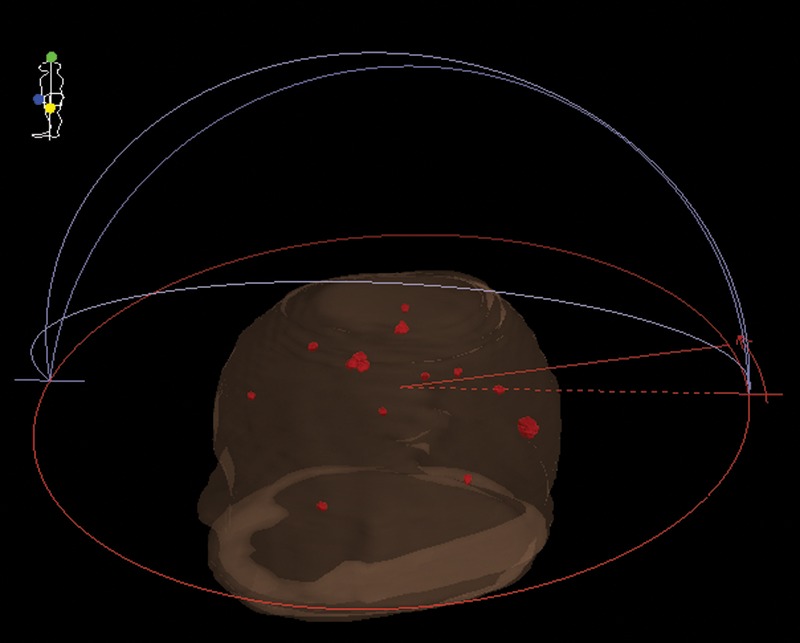
3D head view for a single-isocenter clinical 14 brain metastases (14-mets) VMAT radiosurgery plan with a full arc and three half arcs. The target volumes ranged from 0.03–0.71 cm3.